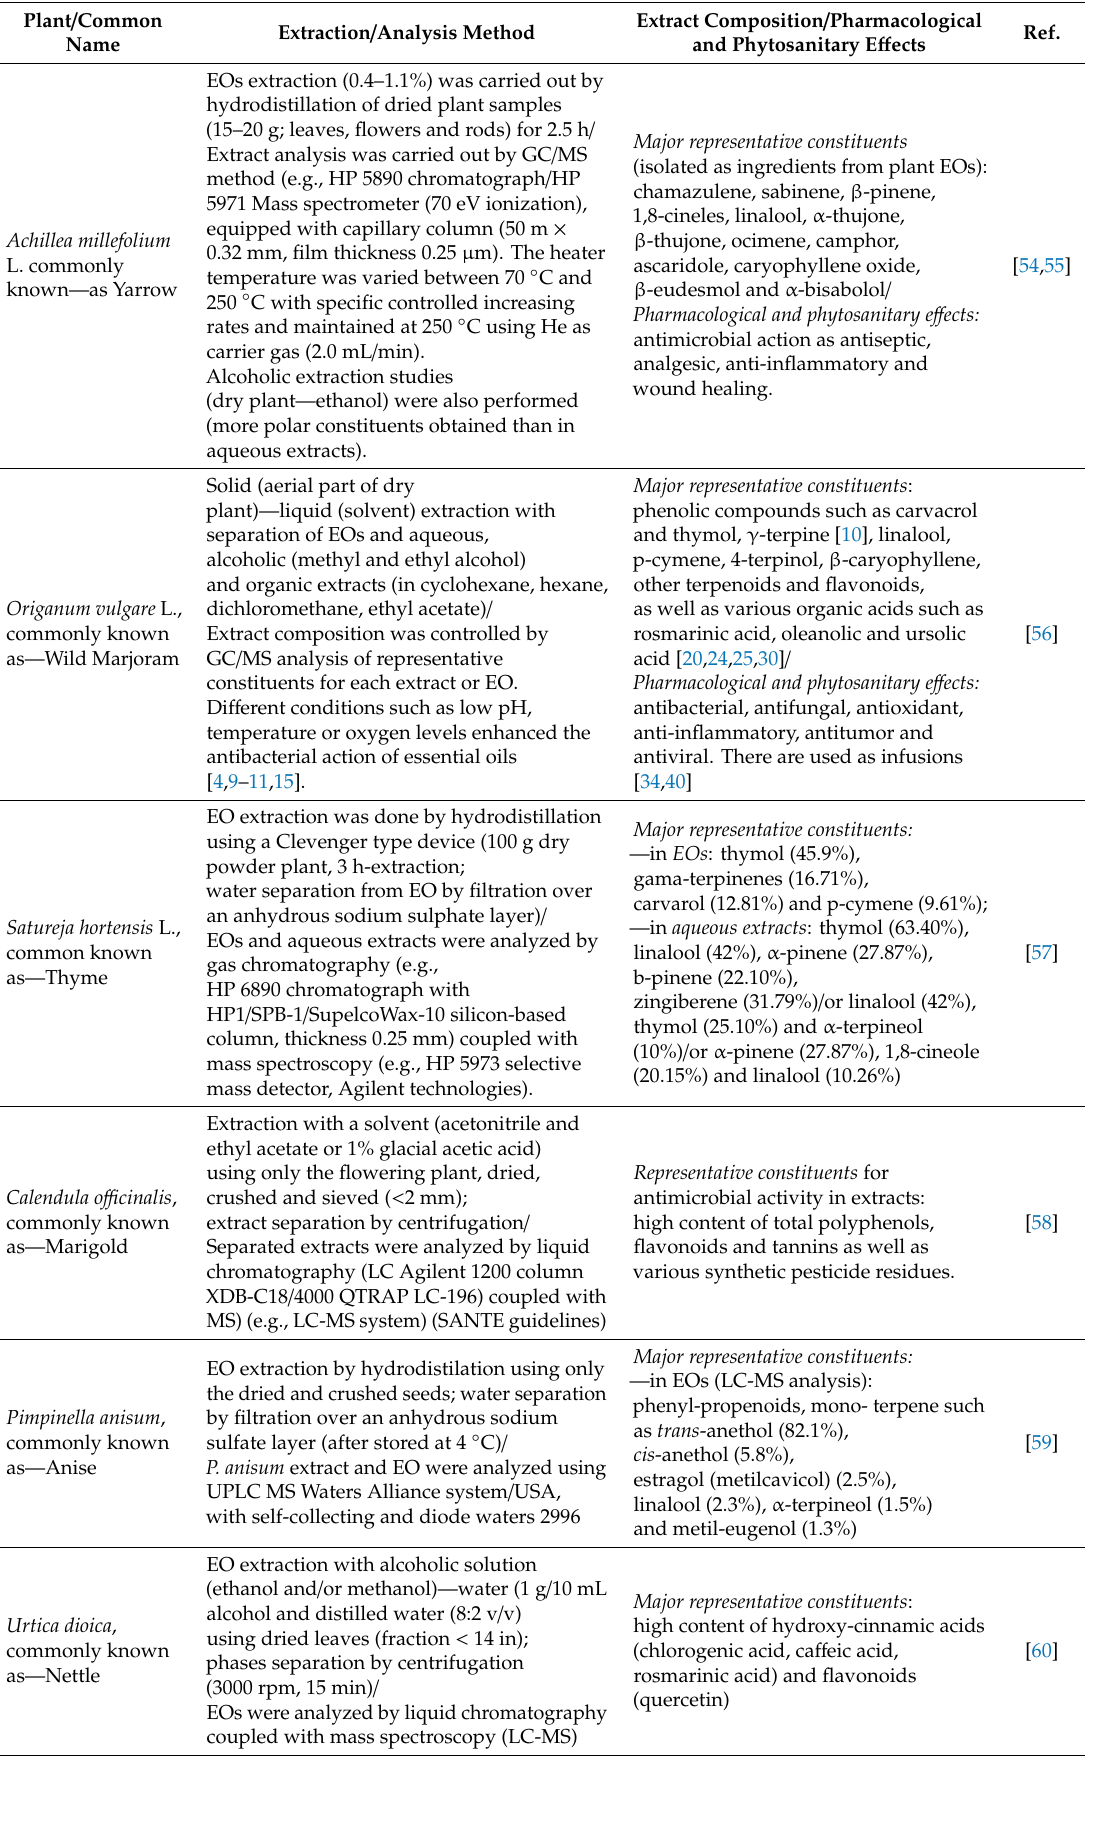
Table 2. Methods used to obtain plant